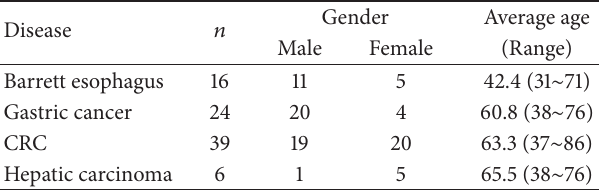
Table 1: Patients’ clinical